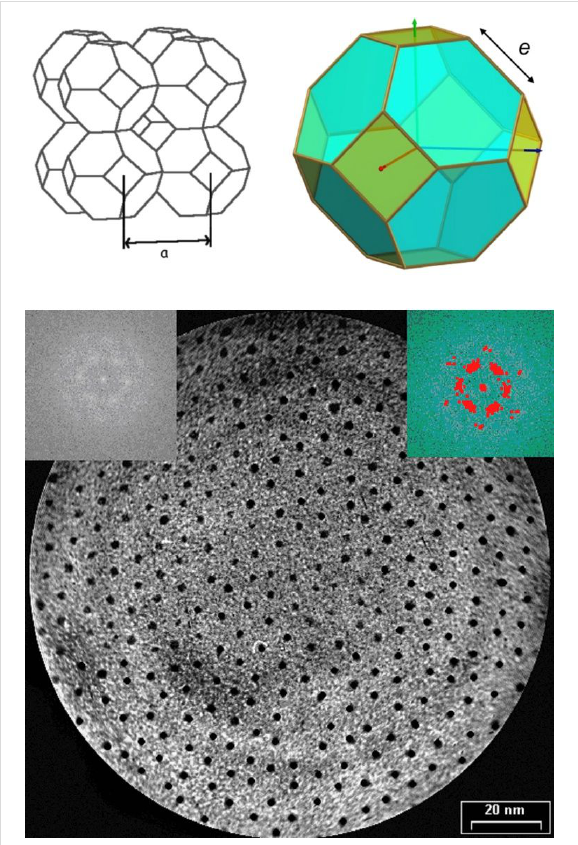
Figure 22: Top left: Body-centred (I) cubic lattice of symmetry composed of truncated octahedrons. Top right: The truncated octa- hedron—a semiregular Archimedean tetradecahedron. Bottom: